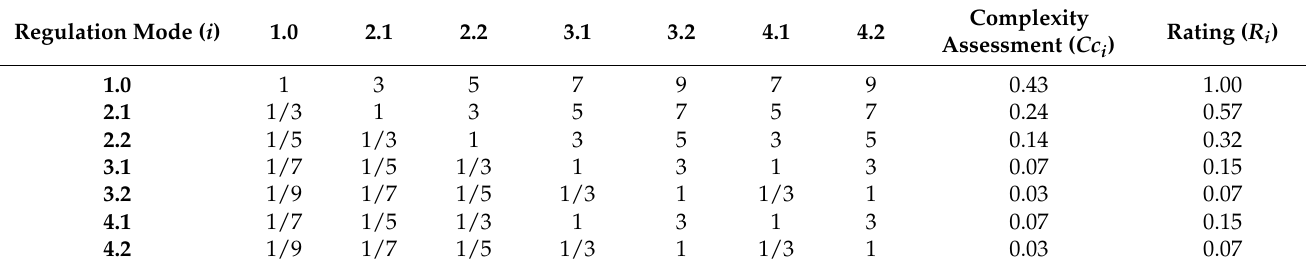
Table 2. Regulation modes